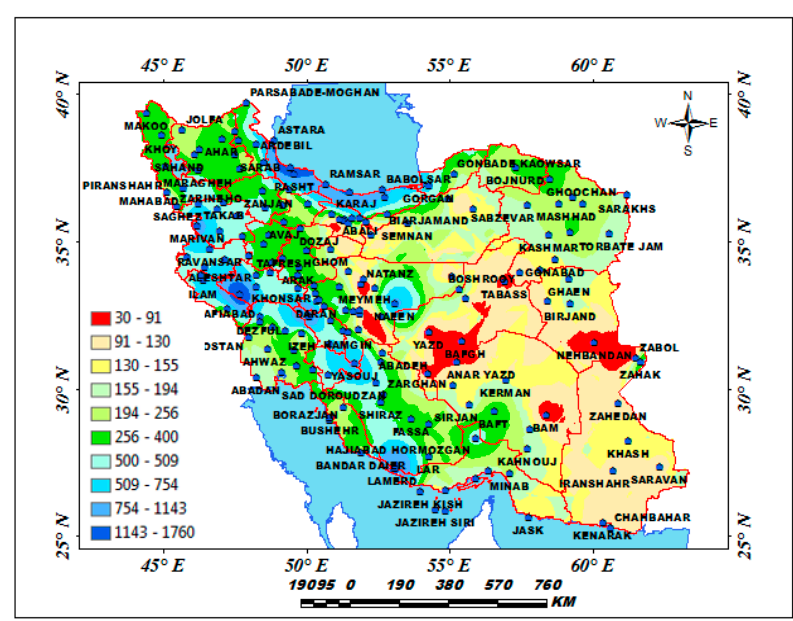
Figure 4. Distribution of Annual Rainfall.